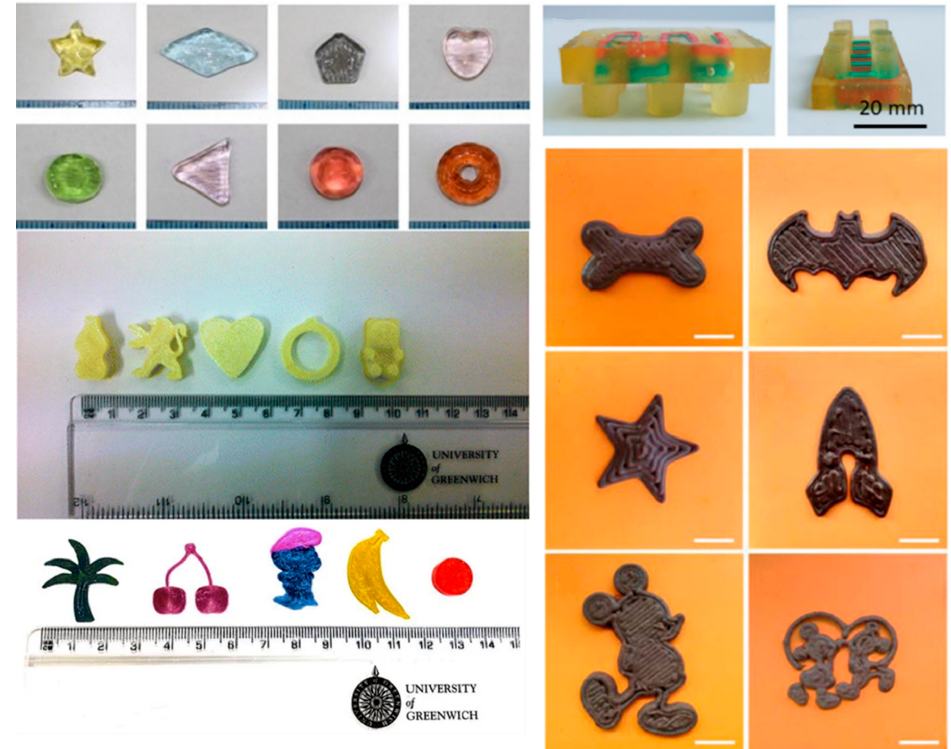
Figure 3. 3D-printed solid dosage forms for pediatric patients; gummy dosage forms ( upper left ) [41]; dosage forms shaped like candy (Starmix ® ) ( middle left ) [42]; taste-masked chewable dosage forms in various shapes ( lower left ) [43]; soft chewable Lego ™-shaped dosage form ( upper right ) [44]; chocolate-based dosage forms in various shapes ( lower right )